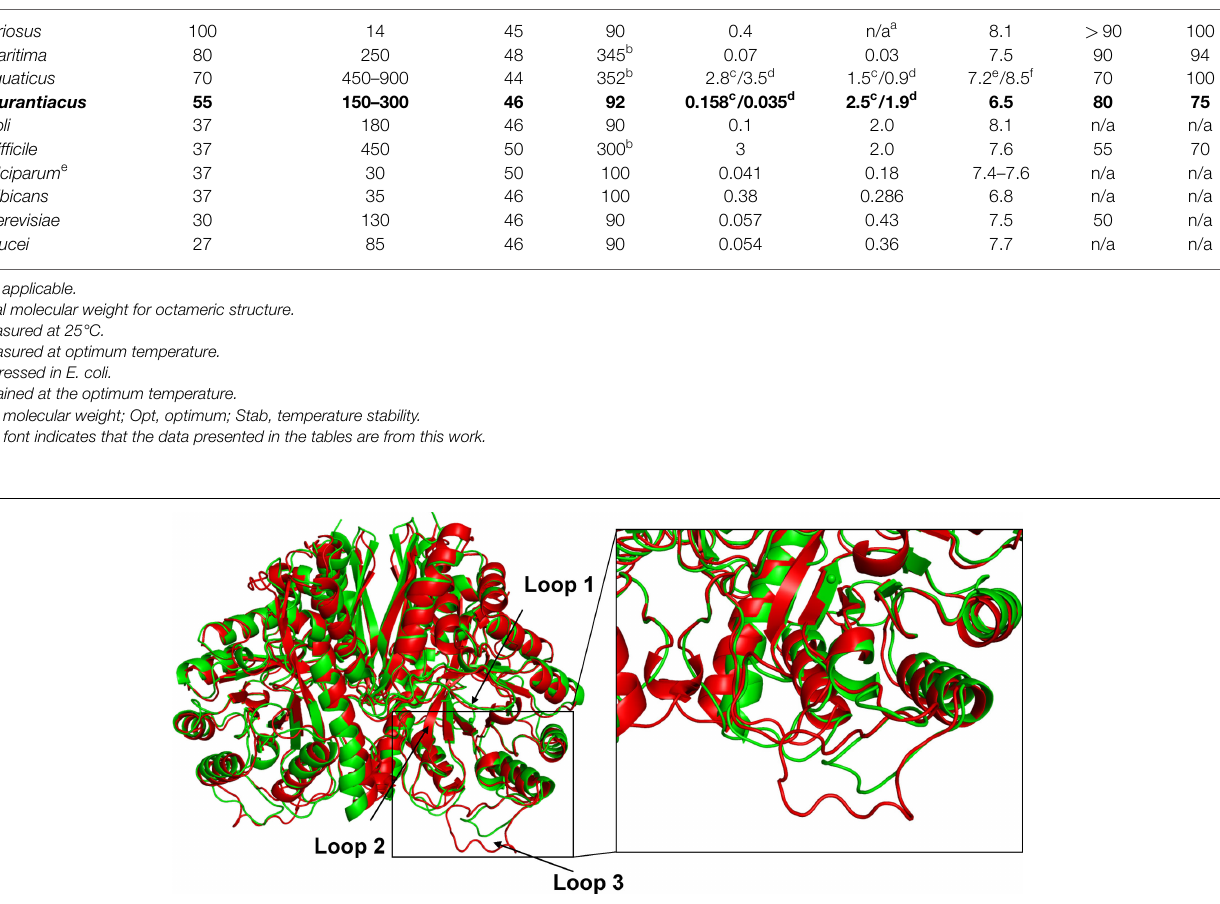
TABLE 3 | Properties of organisms from which enolase have been characterized, and properties of the purified enzymes . Organism Growth temperature, °C